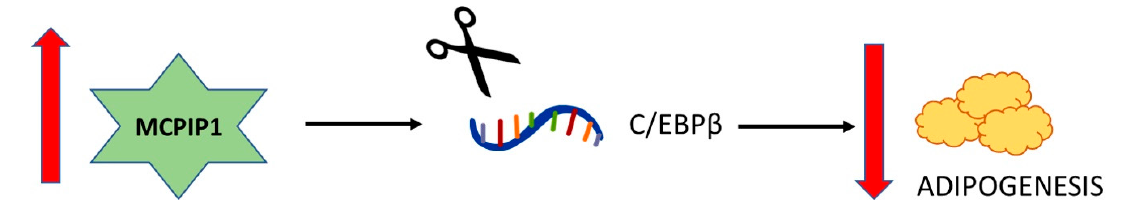
Figure 5. Schematic relationship between the level of MCPIP1 and adipogenesis. A. The overexpression of MCPIP1 decreases the C/EBP β mRNA level and impairs adipogenesis.